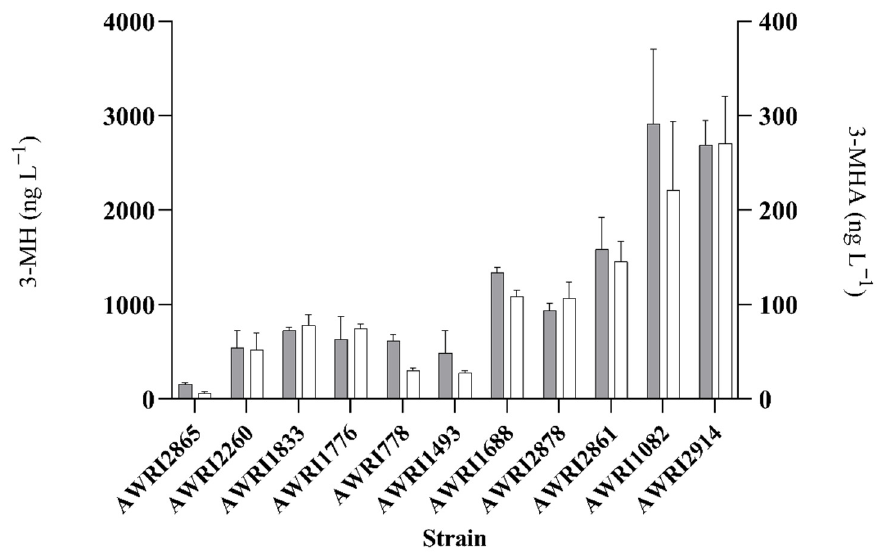
Figure 2. Concentration of 3-MH (grey) and 3-MHA (white) in wine after fermentation of a Pinot Noir must (220 mL) by 11 yeast strains with different IRC7 genotypes. Each bar (in ng L − 1 ) represents the mean and standard deviation of three independent fermentation replicates. In the graph, the 11 yeast strains are shown in ascending order according to their specific β -lyase activity.